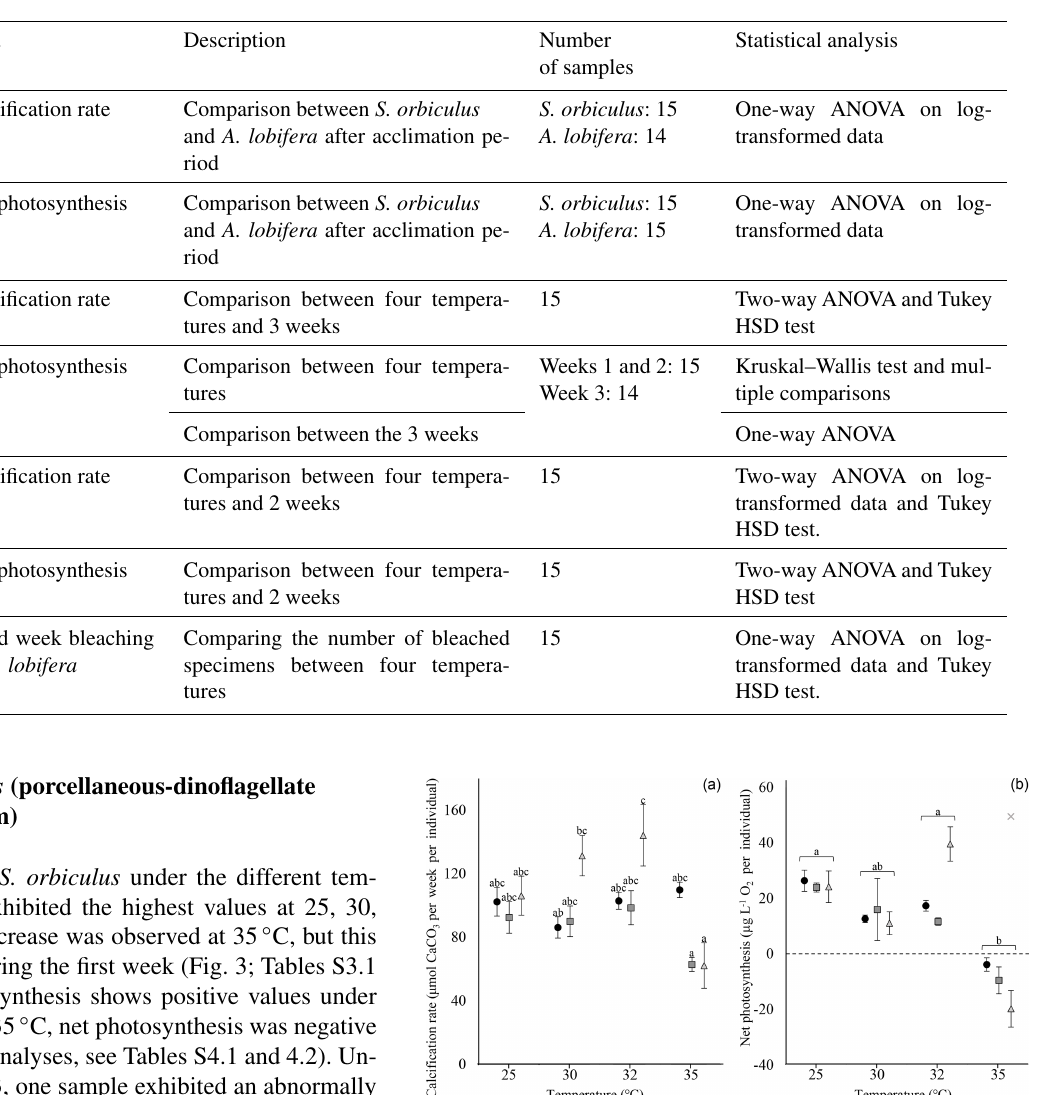
Table 1. Description of all statistical analyses conducted in this study, including the statistical test performed, if data were transformed, and the number of samples in each data set.